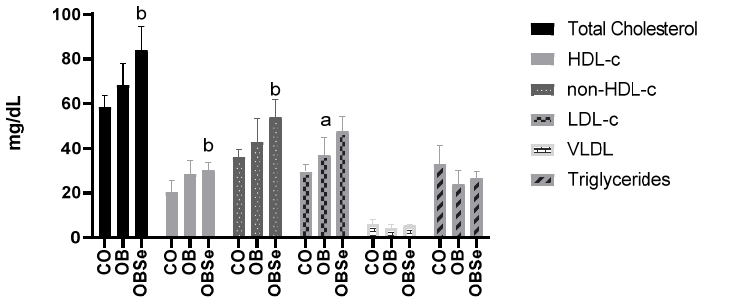
Figure 3. Effects of high-fat obesogenic diet and Se supplementation on total cholesterol and fractions and triglycerides plasmatic levels. Data represent the mean ± SEM ( n = 5/group). Statistically significant difference ( p ≤ 0.05) compared to a CO or b OB group according to one-way ANOVA followed by Tukey’s multiple comparisons